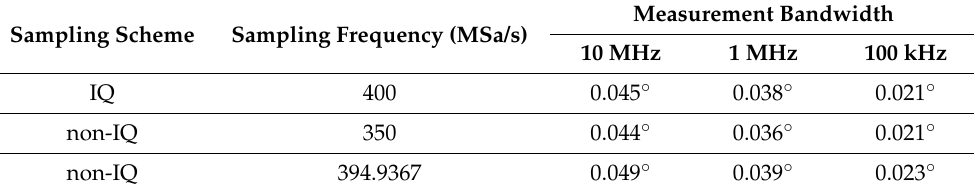
Table 3. Rms phase stability measured across different bandwidths for different sampling schemes and frequencies.